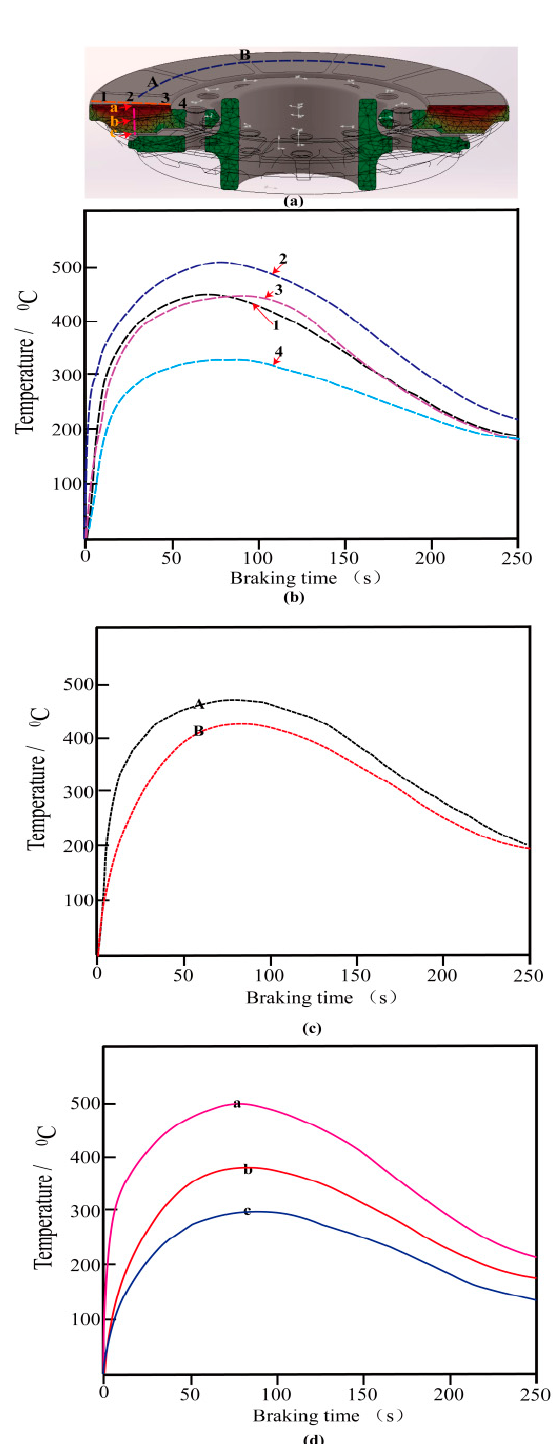
Figure 14. Temperature in the circumference and radial direction versus time at different radii (IBV = 97 m/s, thickness of wear-resisting layer = 4 mm): ( a ) brake disc; ( b ) 1–4 points; ( c ) A,B points; ( d ) a,b,c points.